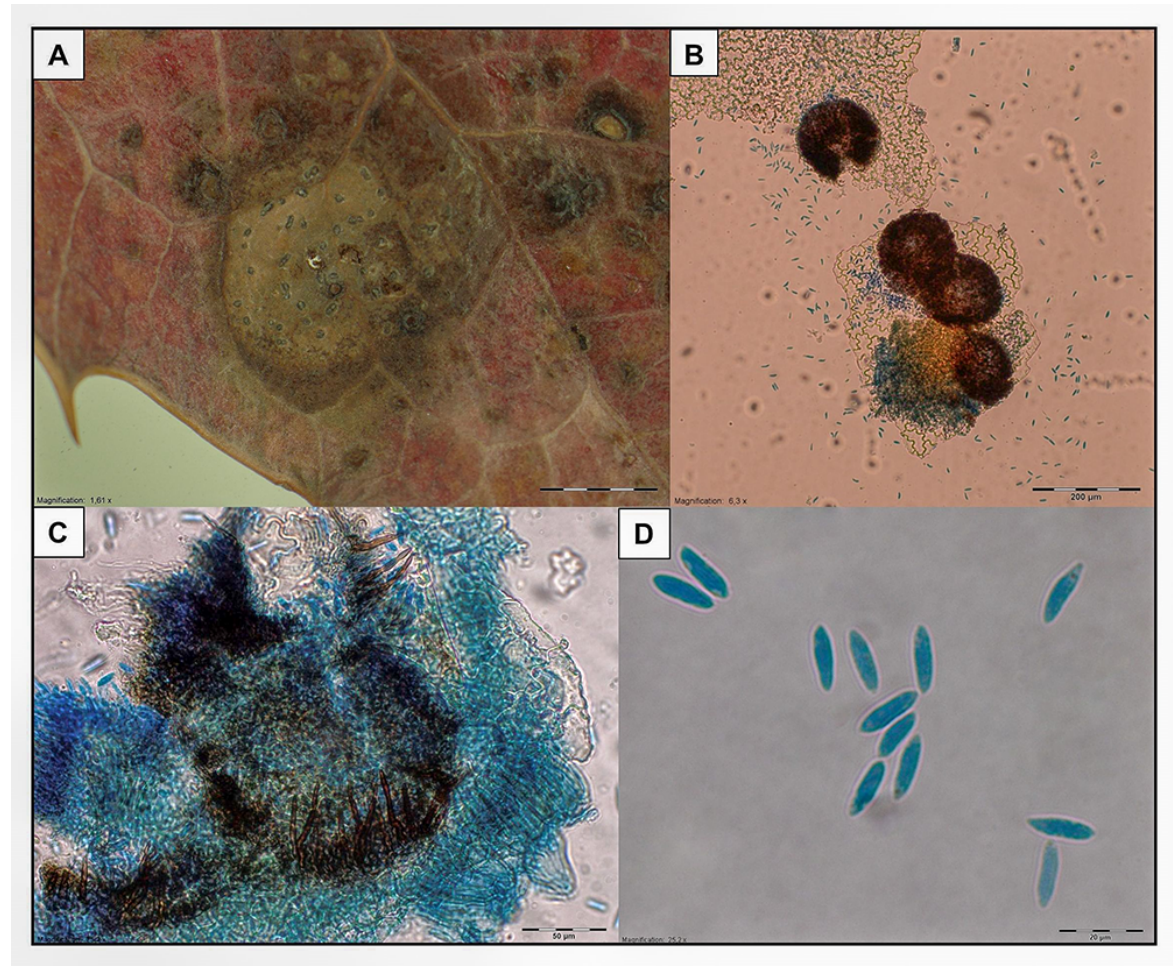
Figure 1 Colletotrichum japonicum on Berberis aquifolium (LBL M–32789). ( A ) Leaf spots with visible acervuli. ( B ) Acervuli. ( C ) Acervulus with setae. ( D ) Conidia. Scale bars: ( A ) 15 mm; ( B ) 200 μm; ( C,D ) 50 μm. Structures in a microscopic preparation stained with cotton blue in lactic acid. Photographs: U.